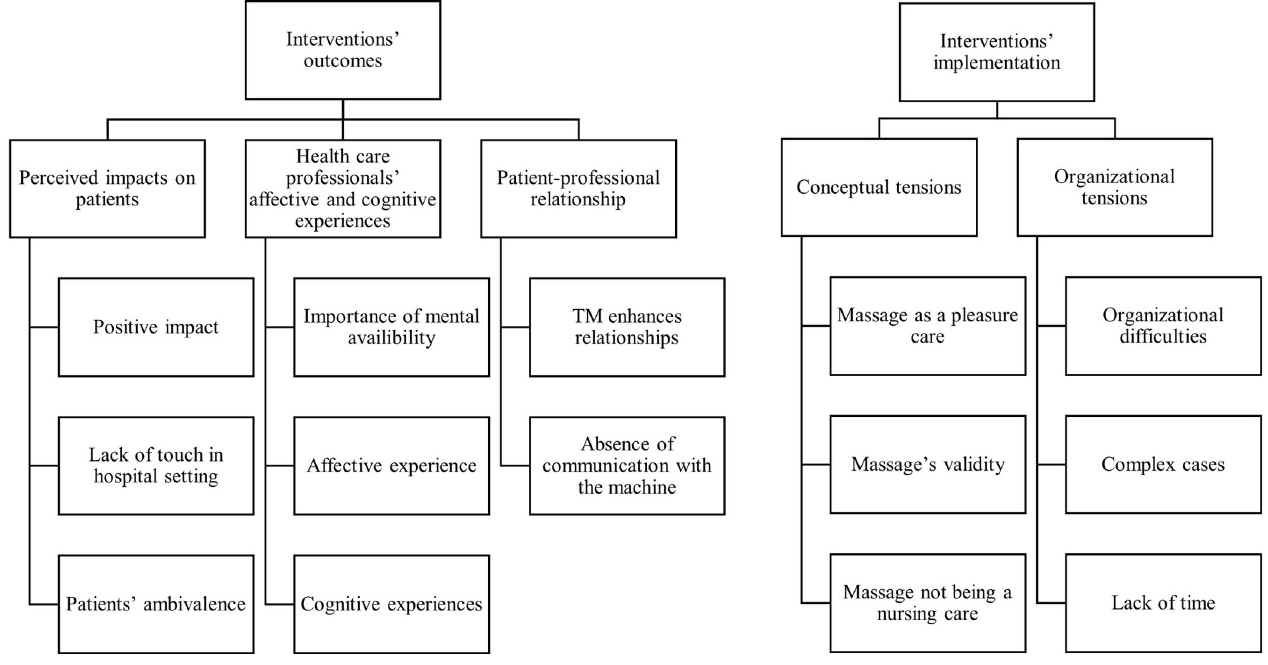
Fig 1. Thematic categorization. Dimensions, themes, and sub-themes.